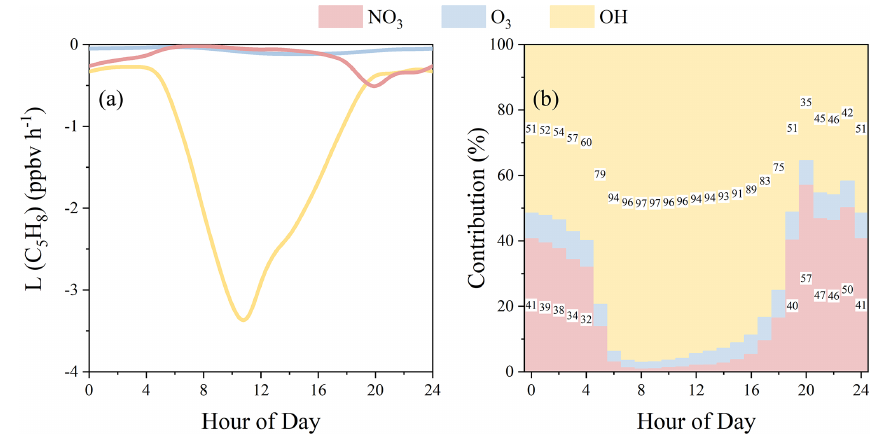
Figure 12. (a) Diurnal loss rate of C 5 H 8 by NO 3 , O 3 , and OH oxidation and (b) their diurnal relative contributions.